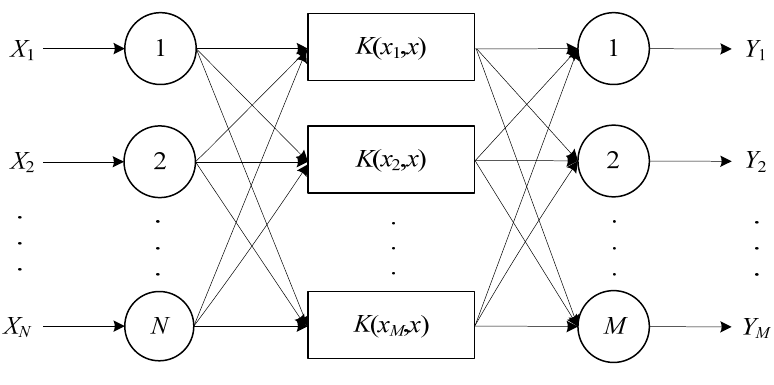
Figure 3. Structure of SVM multiple